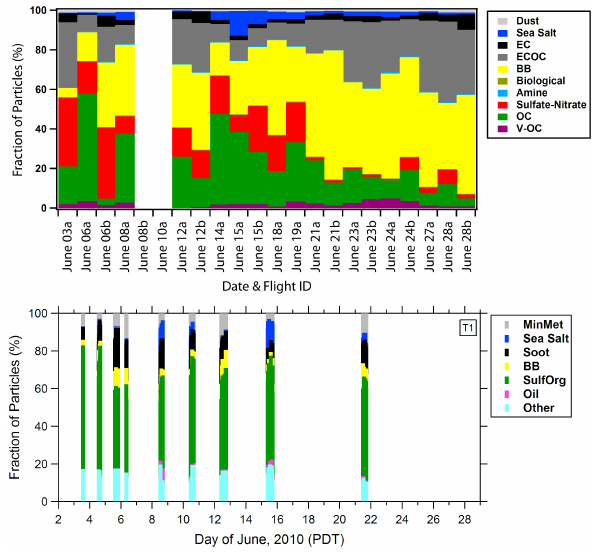
Fig. 12. Variations in fractions of different particles observed by ATOFMS aboard the G-1 (upper panel) and by PALMS at the T1 site (lower panel). EC is elemental carbon, BB is biomass burning particles, V-OC is organic particles containing vanadium, MinMet is mineral dust and metallic particles.